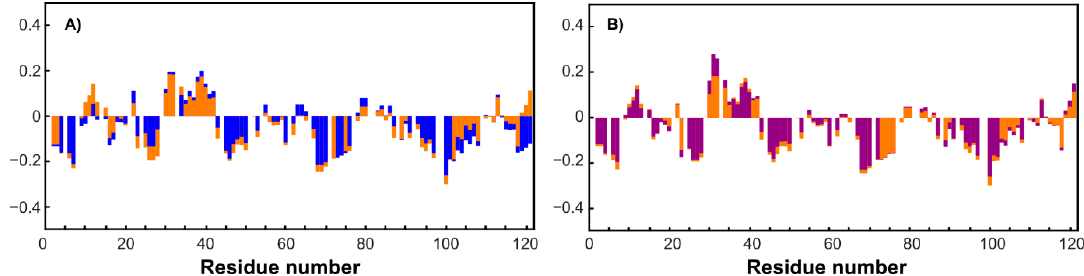
Figure 8. A comparison of SSP scores. ( A ) Blue bars denote RL2 at pH 3.5, and orange ones correspond to acetate buffer, pH 3.9. ( B ) Orange and purple bars denote RL2 and RL2 with TCEP added, respectively, at pH 3.9 in acetate buffer.